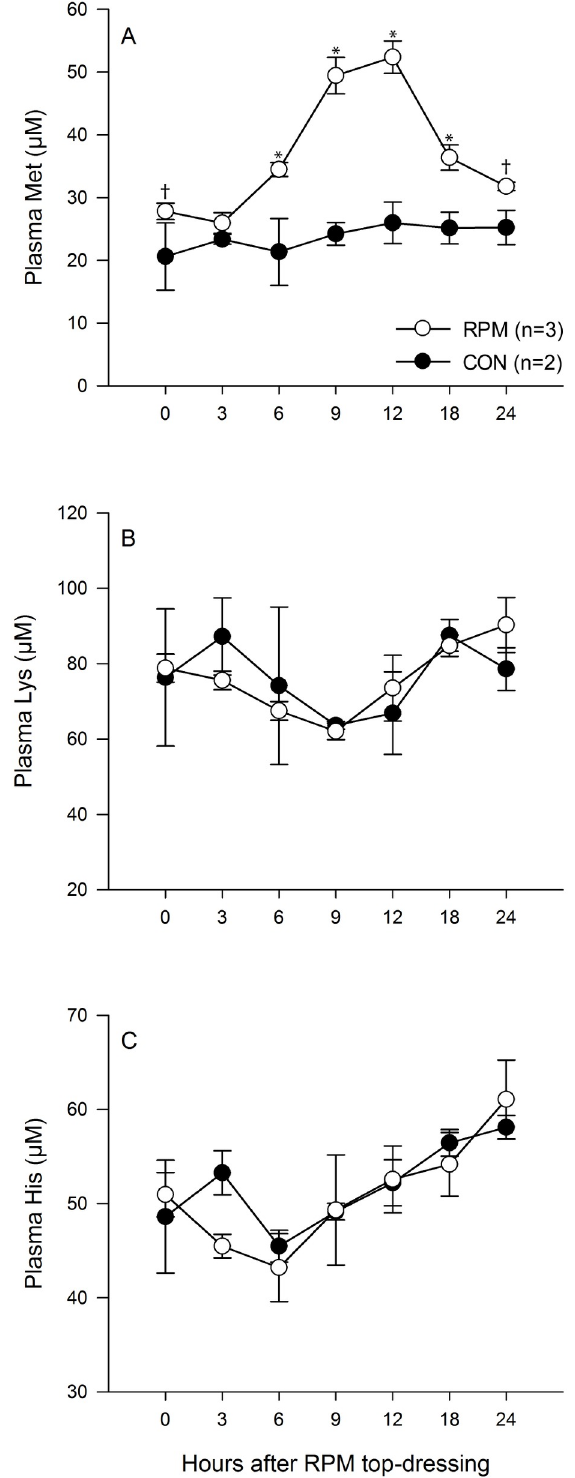
Fig 2. Concentrations of plasma Met (A), Lys (B), and His (C) concentrations after rumen-protected methionine (RPM) top-dressing for CON ( ● ; n = 2 composite samples from 8 cows) or RPM ( (cid:14) n = 3 composite samples from 12 cows). For Panel A, there was an effect of treatment (P < 0.001),